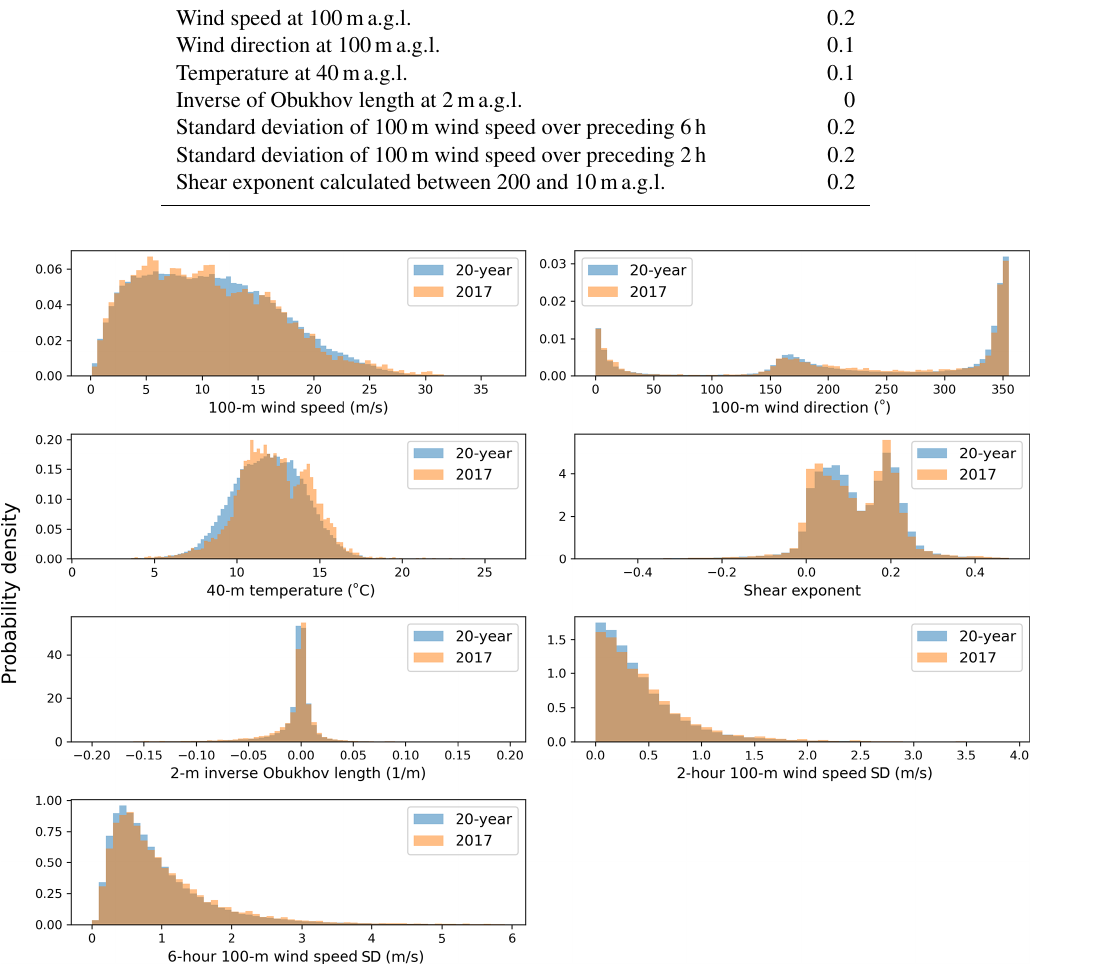
Figure 3. Distributions of the atmospheric variables considered as inputs to the machine learning and AnEn algorithms from 2017 only and from the full 20-year period for a single site within the Humboldt wind energy lease area. Data are expressed in terms of their probability